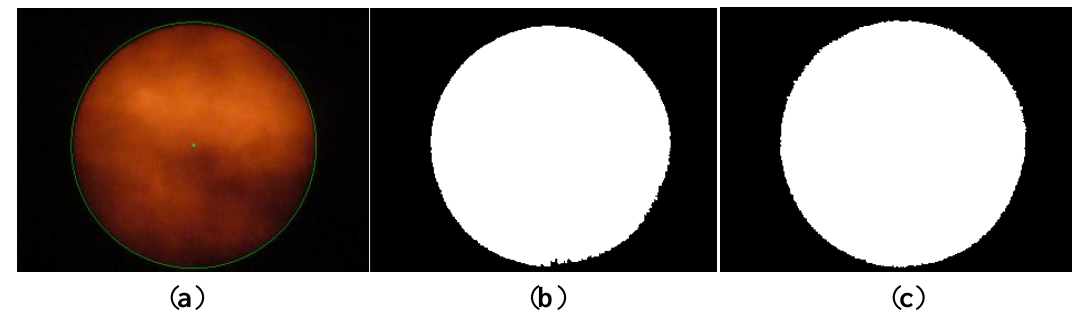
Figure 6. ( a ) Sun picture of sky with some clouds; ( b ) Binarization with L: 0.078~1.0; ( c ) Binarization with L: 0.039~1.0.